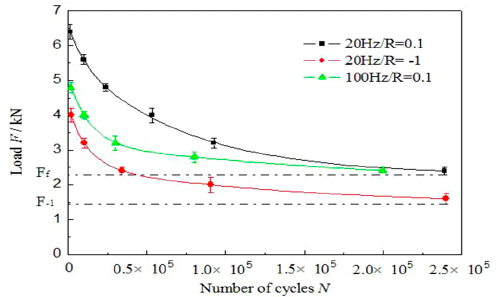
Figure 4. F-N curve of fatigue of dissimilar Al/steel keyhole-free FSSW joints.